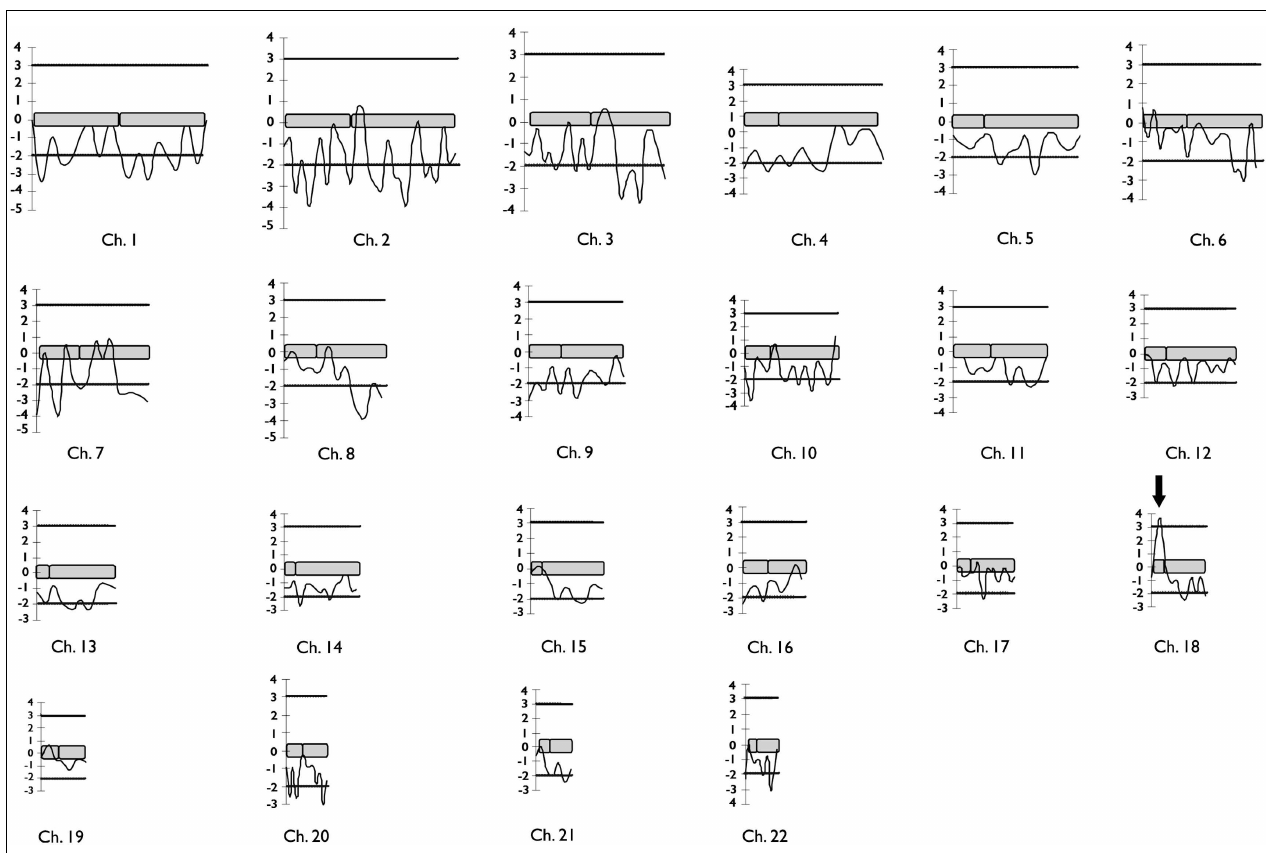
Horizontal lines mark the upper and lower limits for LOD score significance. The arrow indicates the single significant positive LOD score found in the genome scan.